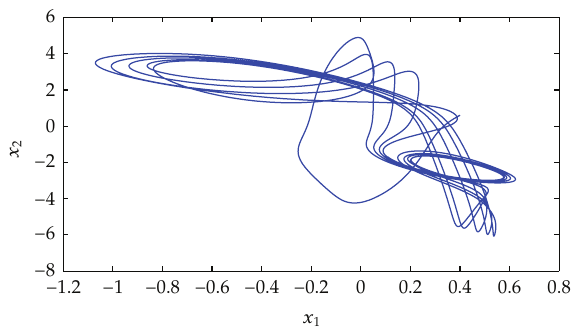
Figure 1: Chaotic and chaotic attractor.